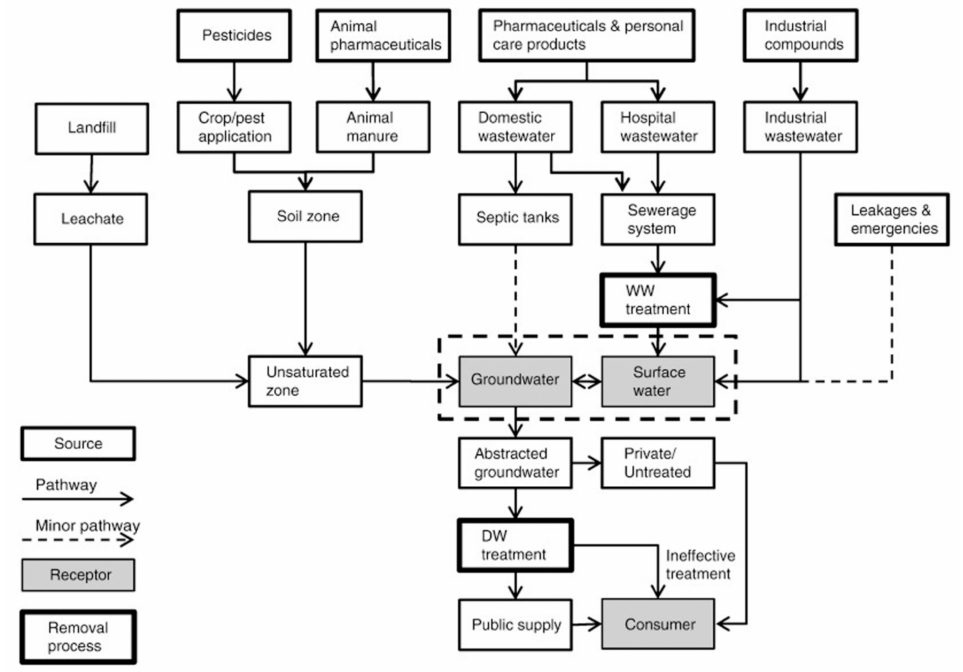
Figure 5. Sources (bold) and pathways for emerging contaminants to reach various receptors (grey) [73]. (Reproduced from [73] with Elsevier permission, license 4912431334481, from 19 Septem- ber